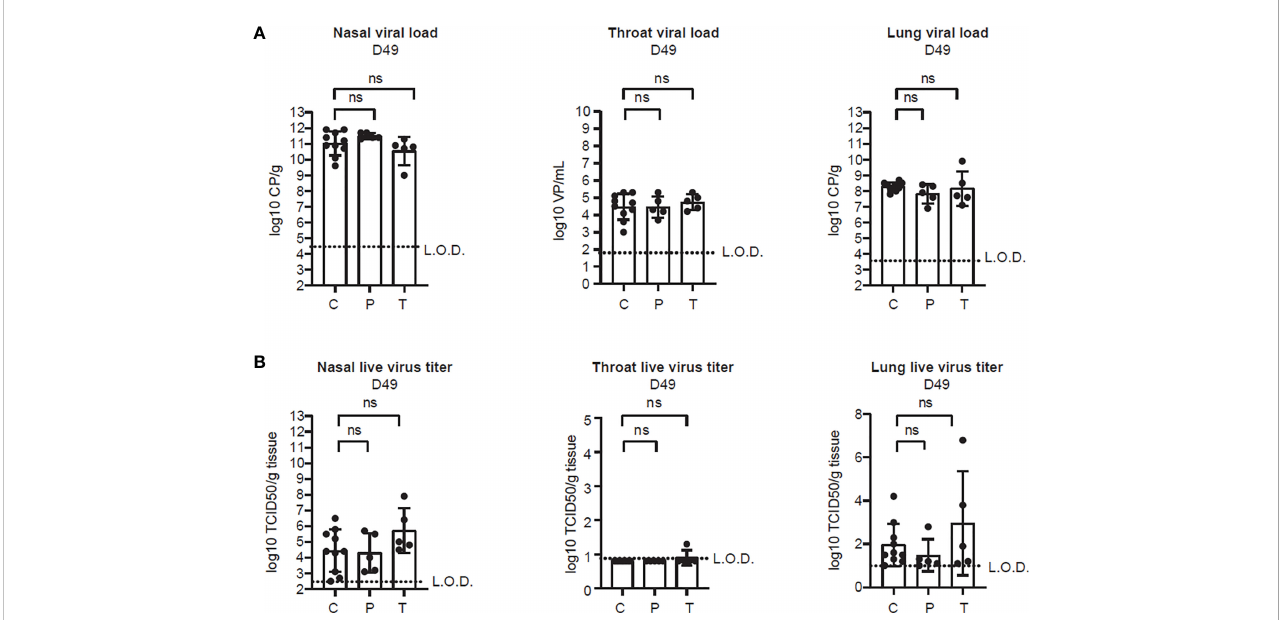
FIGURE 4 PolyPEPI-SCoV-2 does not alter viral clearance from the respiratory tract. (A) Viral load in the lung tissue, nasal turbinates and throat, determined on D49 by PCR. Results are shown as average of log10 VP/mL or log10 CP/mL ± SD of 5 animals per group (or 10 in the Controls group). (B) Replication- competent virus isolated from the lung, nasal turbinates and throat, measured by TCID50 assay on D49. Results are shown as average of log10 TCID50/ gram tissue ± SD of 5 animals per group (or 10 in the Controls group). Dotted lines indicate the limit of detection (LOD). CP, crossing-point value, TCID50/g: 50% tissue culture infective dose per gram tissue, VP, virus particles, C, Controls (combined challenge and adjuvant controls), P: prophylactic, T: post-exposure prophylactic. ns, non-signi fi cant result, p>0.05 by one-tailed Mann-Whitney